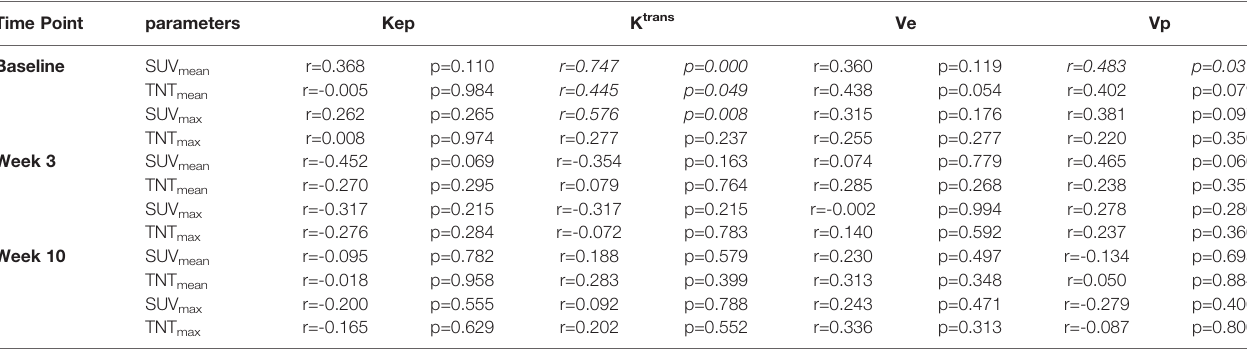
TABLE 4 | Spearman correlation coef fi cient between biomarkers derived from DCE-MRI and 18 F-RGD PET/CT. Time Point parameters